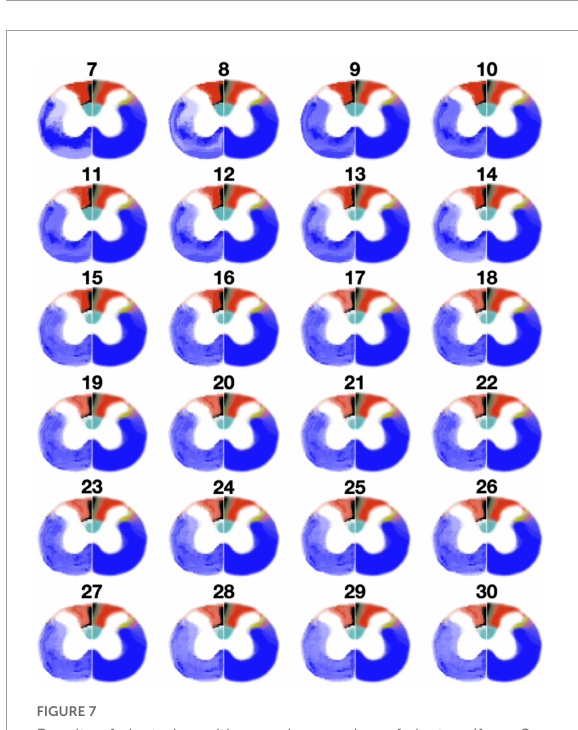
FIGURE8 Violin-plot distribution of axonal density (number of axons per 2500 µ m 2 area) and axon diameter in the rat spinal cord at C1 level in the fasciculus gracilis (FG), the postsynaptic dorsal column (PSdc), fasciculus cuneatus (FC), dorsal corticospinal tract (dCST), lateral cervical nucleus (LatC), lateral spinal nucleus (LSp), rubrospinal tract (RST) and the lateral and ventral funiculi (LF/VF), as defined by the Watson atlas. While the metrics median (red lines) and mean (black lines) vary across tracts, their distribution clearly overlap. Modified with permission from Saliani et al.